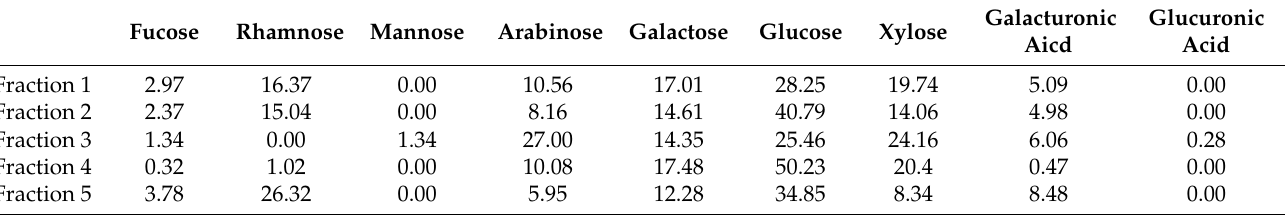
Table 3. Total carbohydrate composition (%, w / w ) after hydrolysis of five flaxseed protein- polysaccharide natural